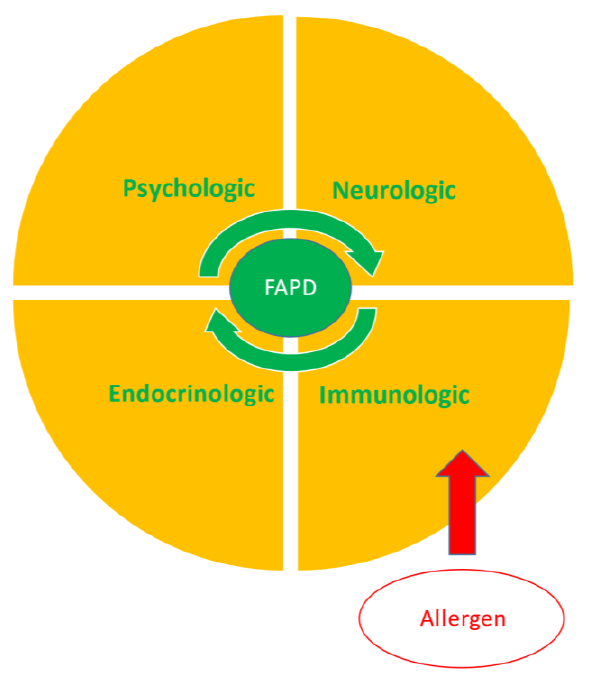
Figure 1. Four primary interacting systems generate the symptoms of functional abdominal pain disorders (FAPDs). This process can be initiated, maintained, or exacerbated by allergens through activation of the immune system.